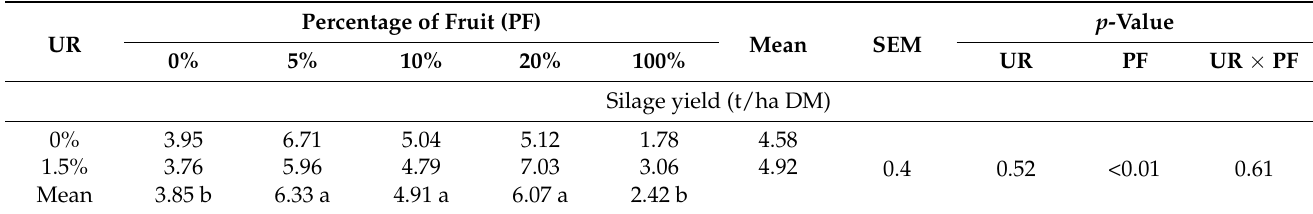
Table 2. Yield of silages with different mixtures of melon biomass and addition of urea.